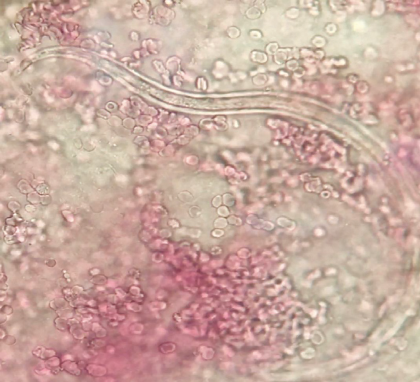
Figure 3: Strongyloides stercoralis parasite present in the